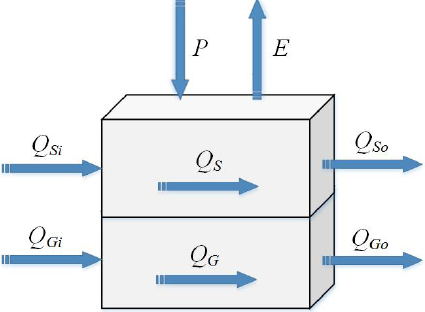
Figure 8. The water exchange processes in a non-channel grid cell.